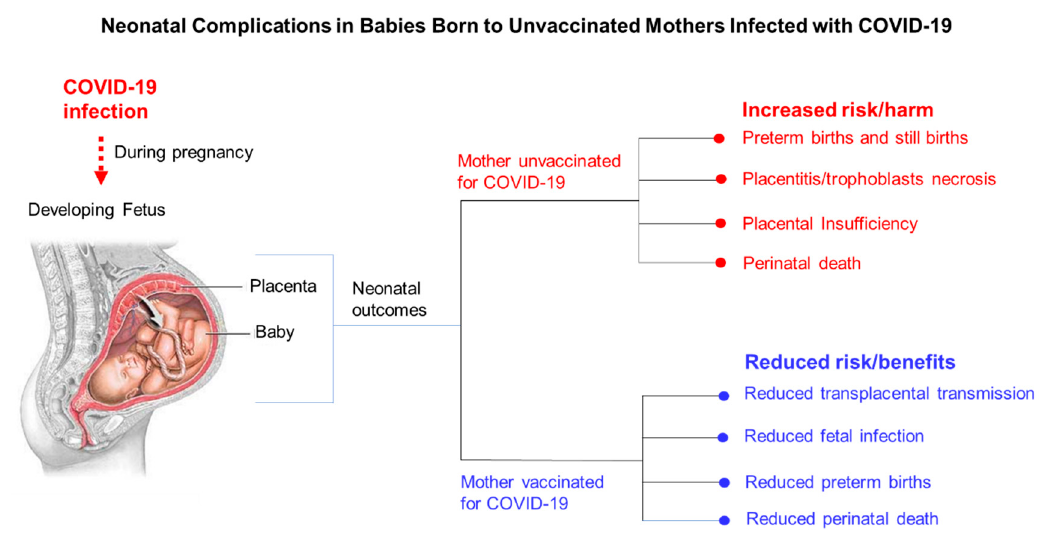
Figure 3. Neonatal complications observed in babies born to infected mothers who were unvaccinated for COVID-19.